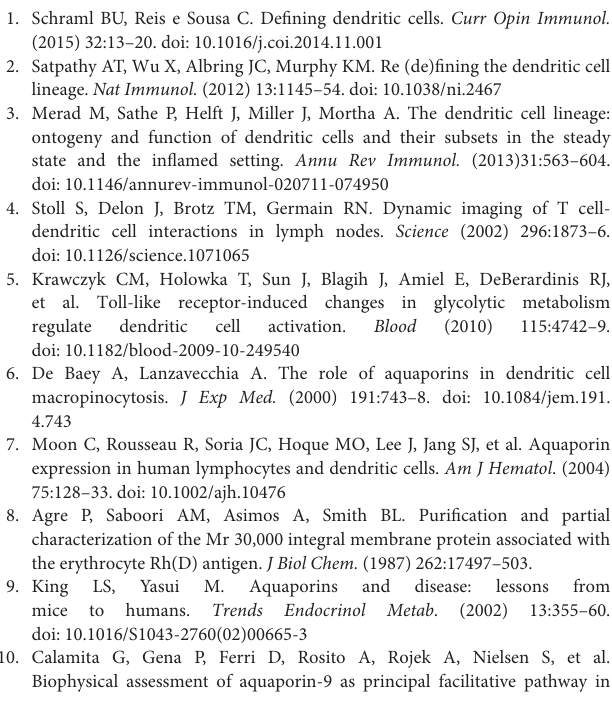
Supplementary Figure 1 | Representative amplification plot using AQP1 and AQP5 probes. Supplementary Figure 2 | IL12p70 production by HTS13286 treated DCs. Mature BMDCs were exposed to HTS13286 at the indicated times. IL-12p70 secretion was determined 24h later by ELISA. ∗ P < 0.05, ∗∗ p < 0.01, ∗∗∗ p < 0.001. Supplementary Figure 3 | The maturational profile of mature BMDCs was impaired after HTS13286 treatment. Representative dot plot analysis of BMDCs treated with two stimulations of HTS13286 shows a mild decrease of CD11c/MHCII + cells in mature BMDCs after HTS13286 treatment. x Mean values: Vehicle RPMI: 16.5; Vehicle + LPS: 23.1; HTS13286 RPMI: 15.9; HTS13286 + LPS: 18.7 (representative of 3 independent experiments). Supplementary Figure 4 | Surface markers of CD11c enriched cells from different tissues. Representative dot plot analysis of CD11c enriched cells from the spleen, peripheral lymph nodes (PLNs), mesenteric lymph nodes (MLNs) and Peyer’s patches (PPs) of WT mice. (A) MHCII and Ly6G expression from the ungated CD11c enriched cells. (B) CD11c + cells expression of CD11b, F4/80 and CD103. Supplementary Figure 5 | Aqp9 expression during DCs maturation. Bone marrow cells from WT mice were cultured in presence of GM-CSF and IL-4. At indicated time cells were harvested to evaluate Aqp9 expression (histogram). FACS analysis reveal MHCII, Ly6G and CD11c surface expression (dot plot). (representative of 3 independent experiments). Supplementary Figure 6 | AQP9-KO DCs expression of Aqp7 and Aqp3. The expression of Aqp 3 and Aqp7 was assessed in BMDCs from Aqp9-KO mice exposed to LPS for 6 or 24h. White bar represent untreated DCs. Bars represent the mean ± SEM of 3 independent experiments. ∗∗∗ P < 0.001. Supplementary Table 1 | ROBs-QP treatment does not induce significant modulations in the expression of different Aqps in LPS-activated BMDCs. Data indicate the AVG signals of Aqp 1-12 from 4 different